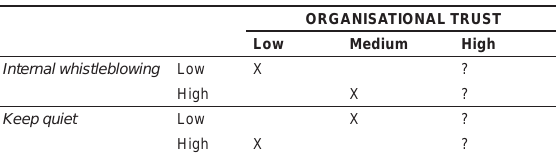
taBle 4 Scale statistics for the adjusted constructs